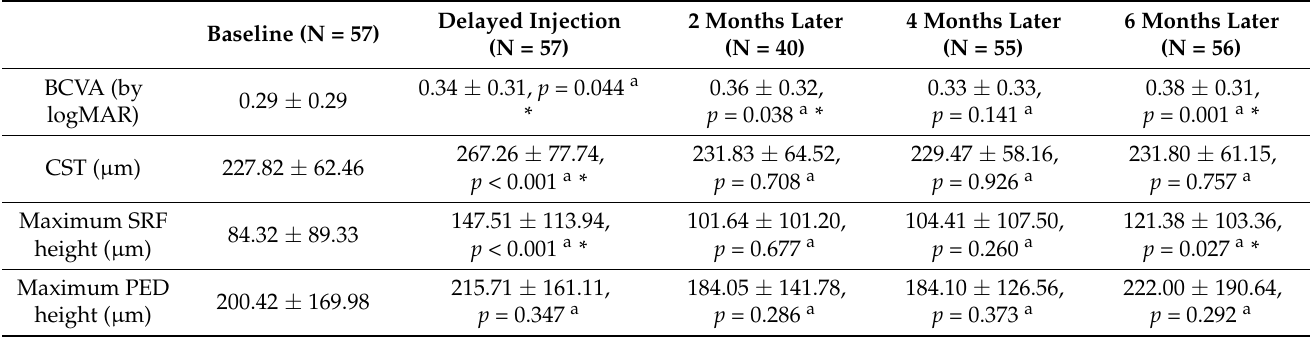
Table 3. Changes in BCVA and OCT measurements during the follow-up period.